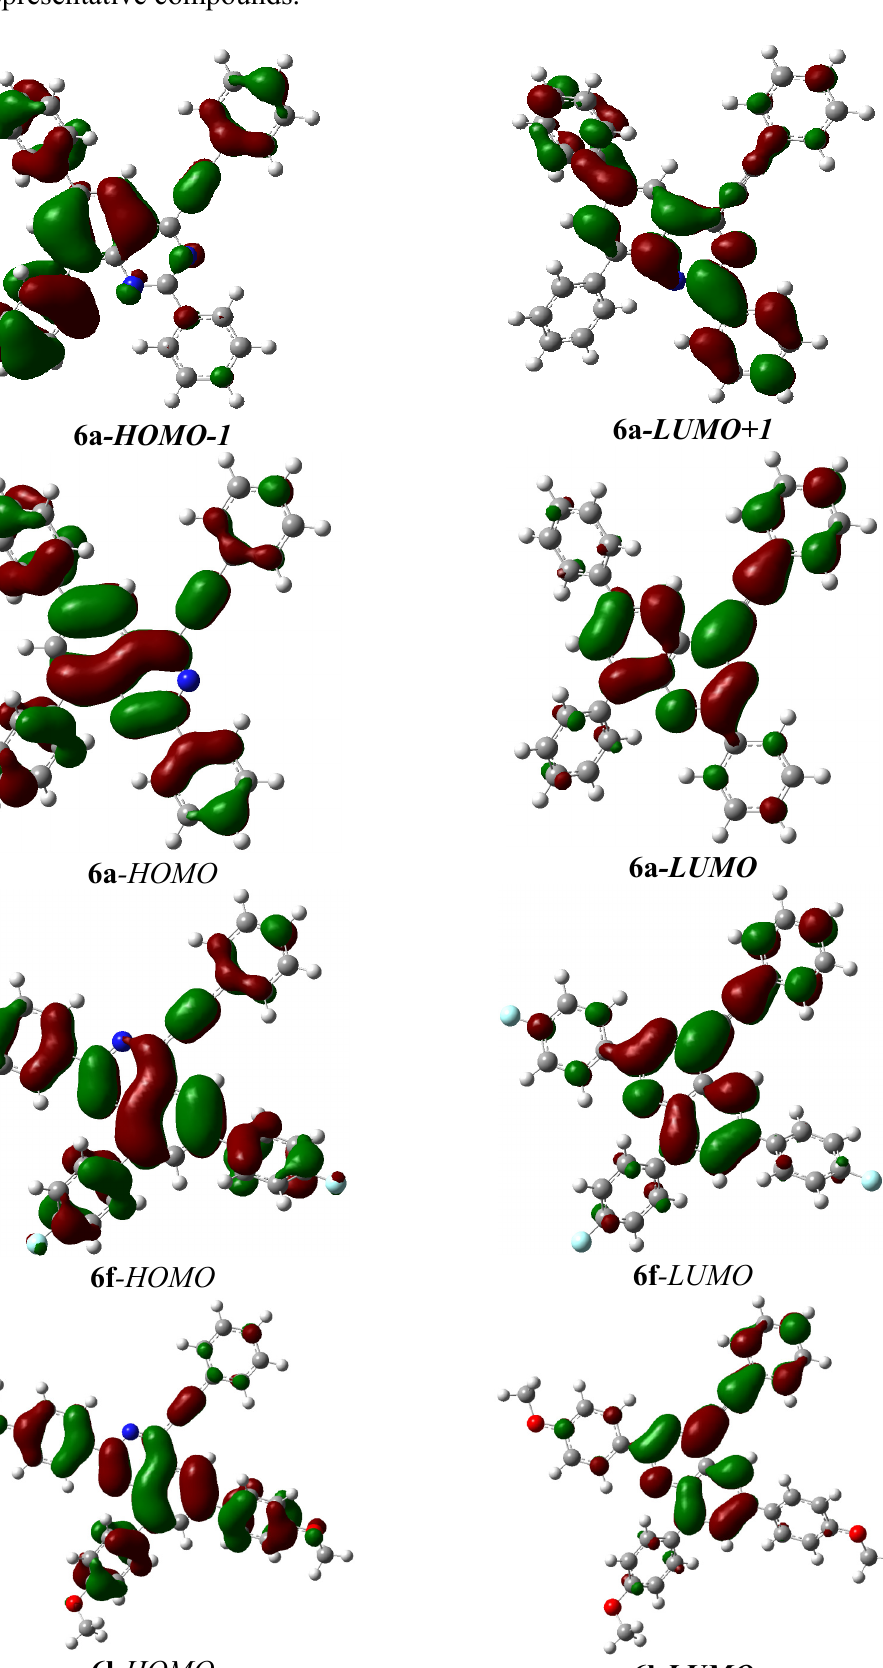
Figure 10. Selected frontier molecular orbitals, HOMO-1, HOMO, LUMO and LUMO+1 of some representative